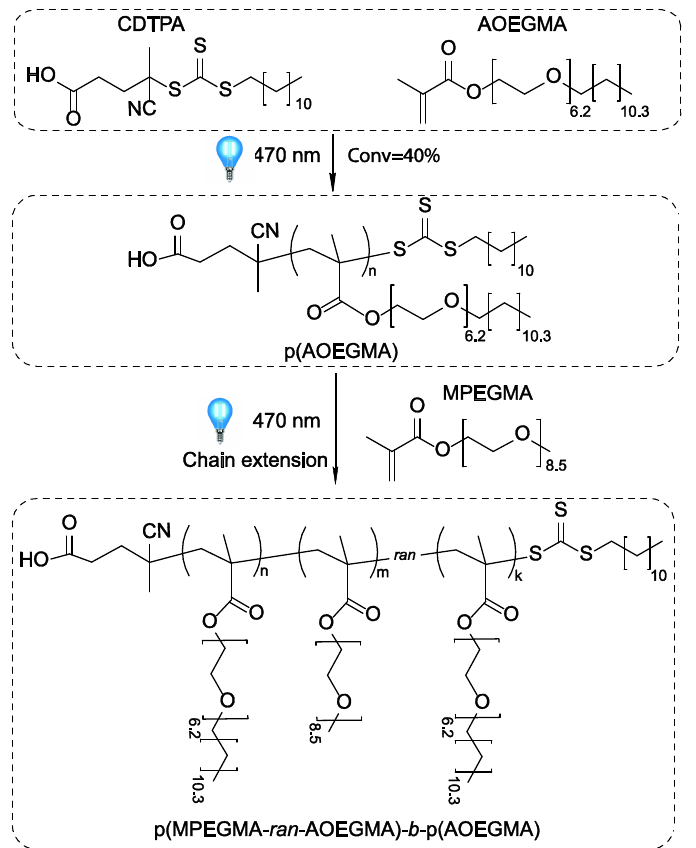
Figure 9. UV–vis spectra of MPEGMA–AOEGMA copolymers in acetonitrile (Ph11 series). Maximum absorption wavelength λmax = 307 nm.